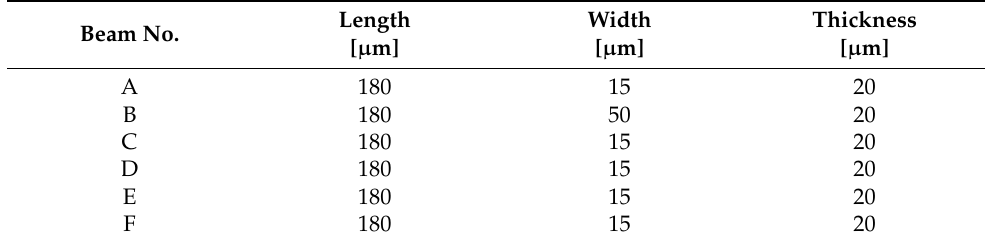
Table 2. Dimensions of each sensing elements. Beam